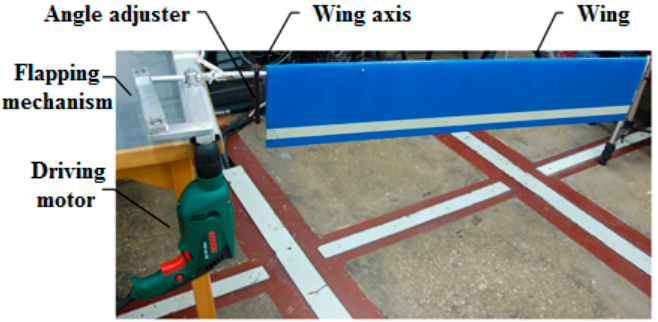
Figure 12. The test set-up and it main parts.